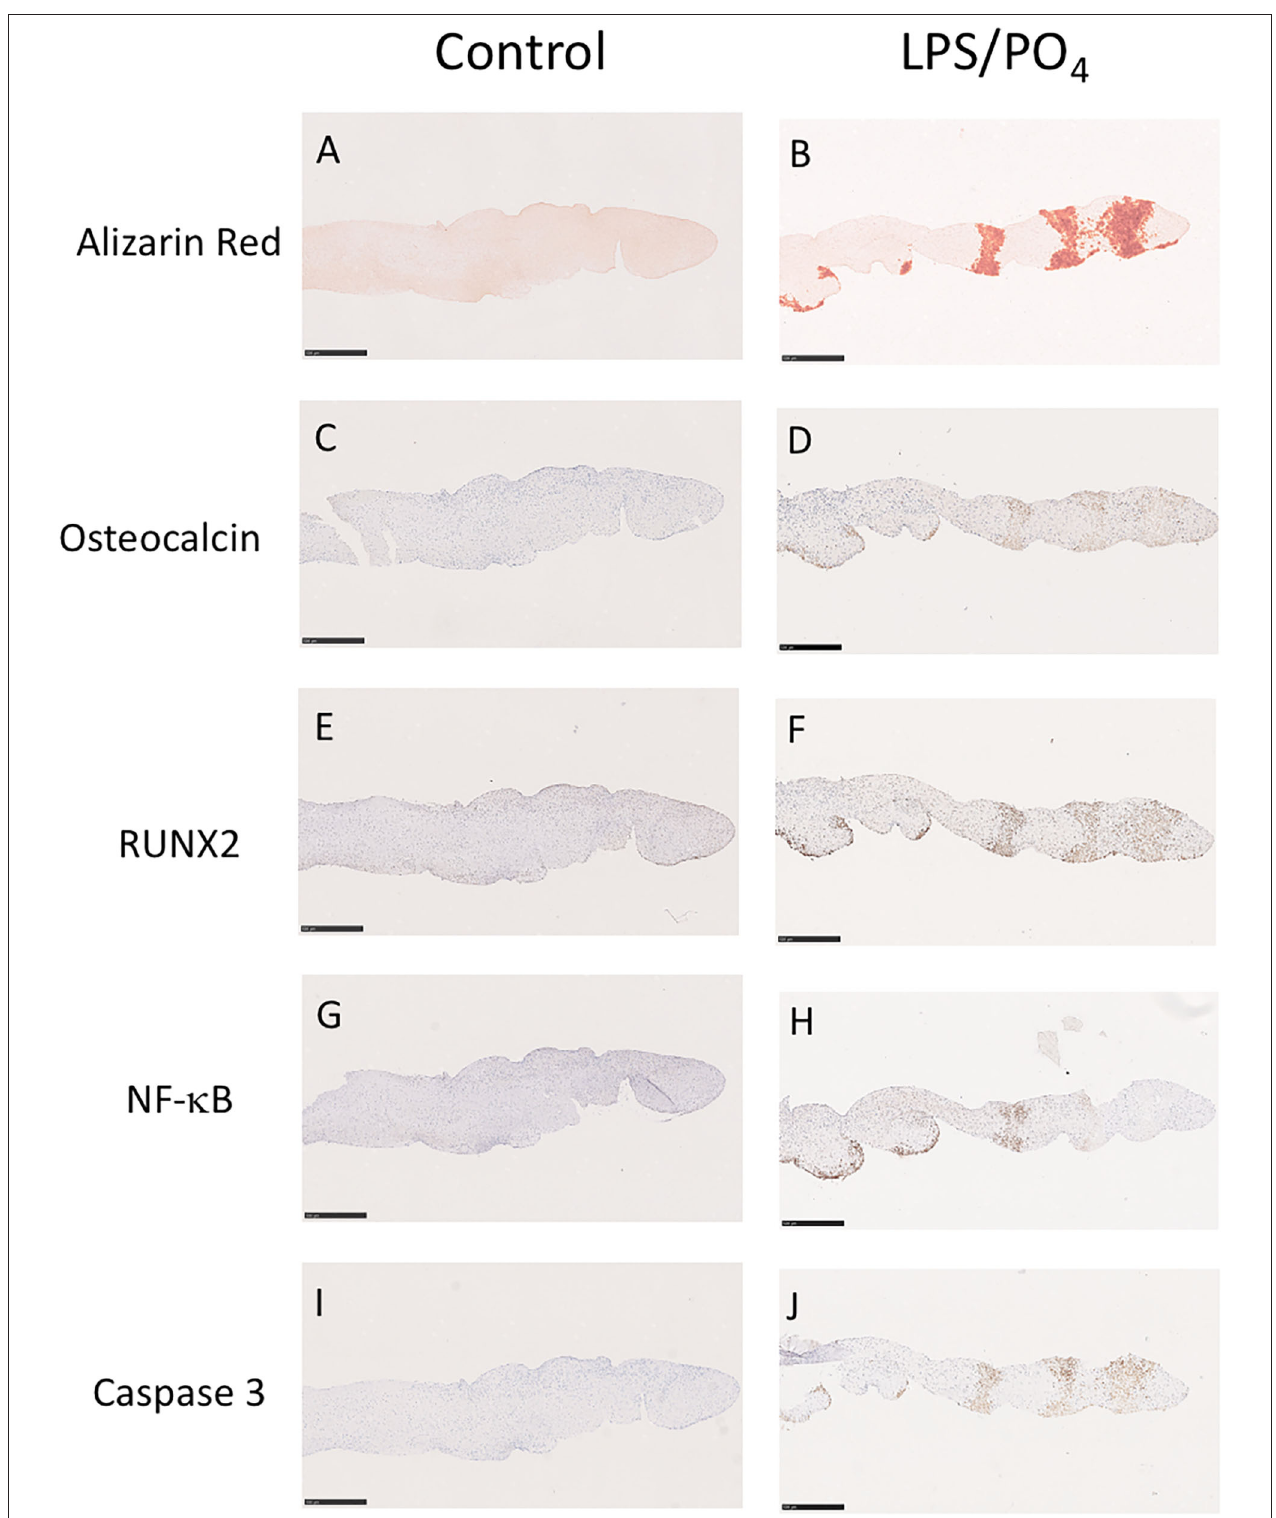
FIGURE 7 | Colocalisation of Alizarin Red staining with osteogenic, inflammatory and apoptotic markers. Sequential sections of a valve leaflet stimulated media alone (left column) or 100ng/mL LPS and 3mM phosphate (right column) for 14-days. Histochemical staining for Alizarin Red (A,B) co-localizes with regions of immunohistochemical staining for osteocalcin (C,D) , RUNX2 (E,F) , NF-kB (G,H) and caspase 3 (I,J) . Scale bar, 500 µ M.